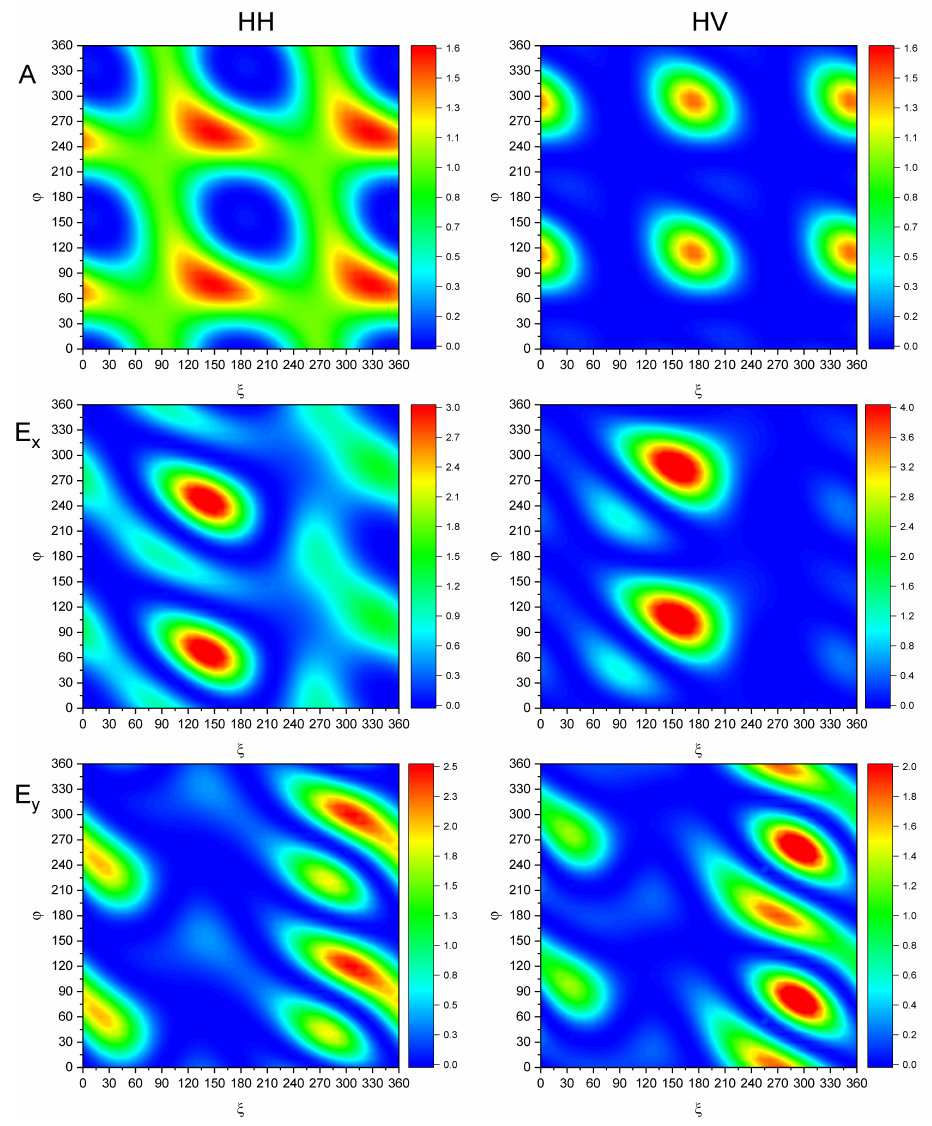
Figure A4. Rotation angle intensity map of calculated Raman modes in HH and HV